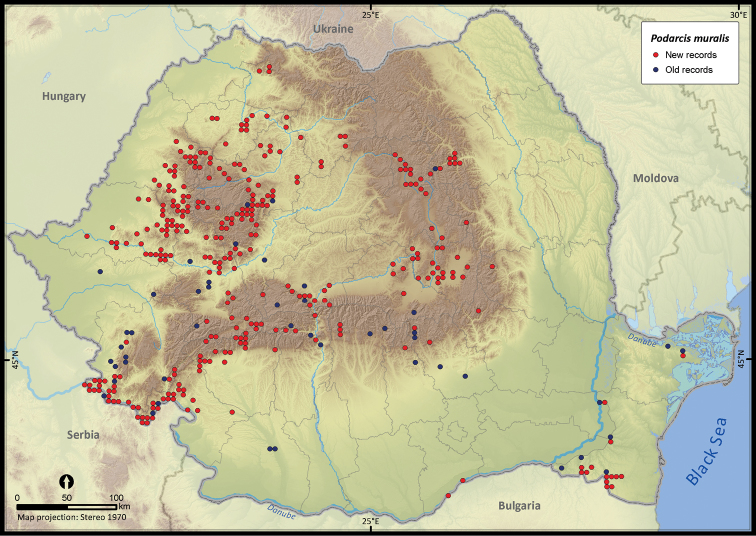
Podarcis muralis.